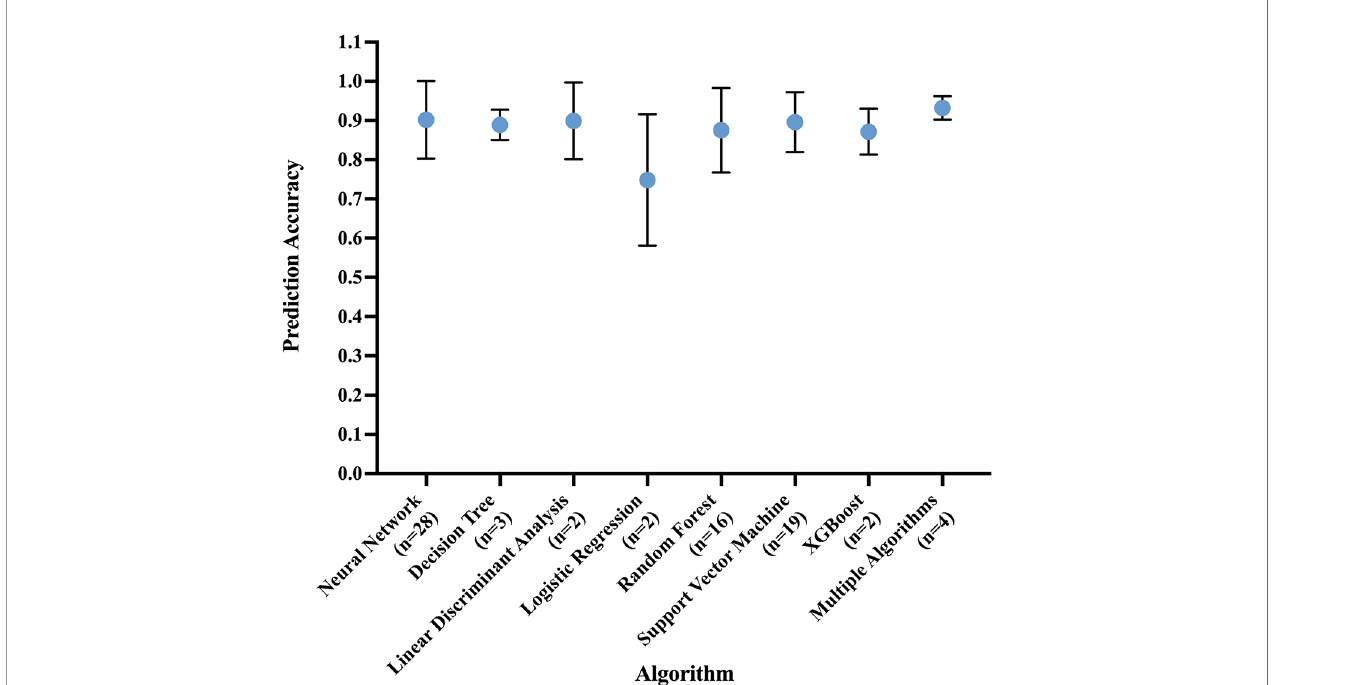
FIGURE 5 | Prediction accuracy of most common algorithm types, measured in the best performing algorithm of each study. Circle at mean. Error bars indicate standard